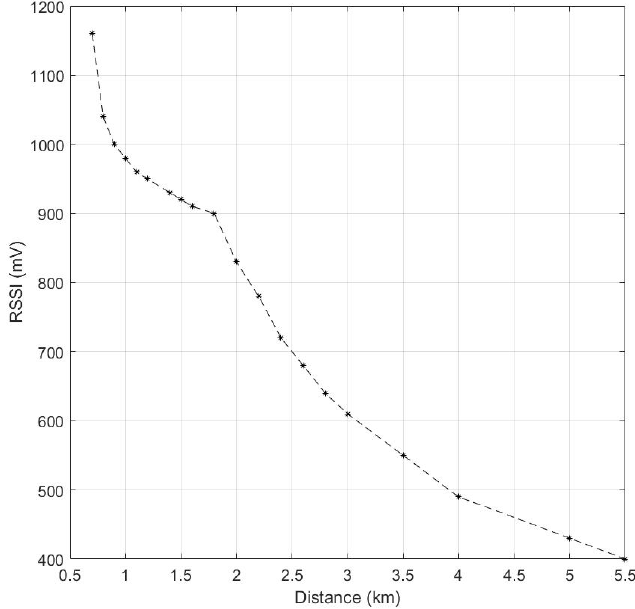
Figure A1. RSSI as a function of distance.